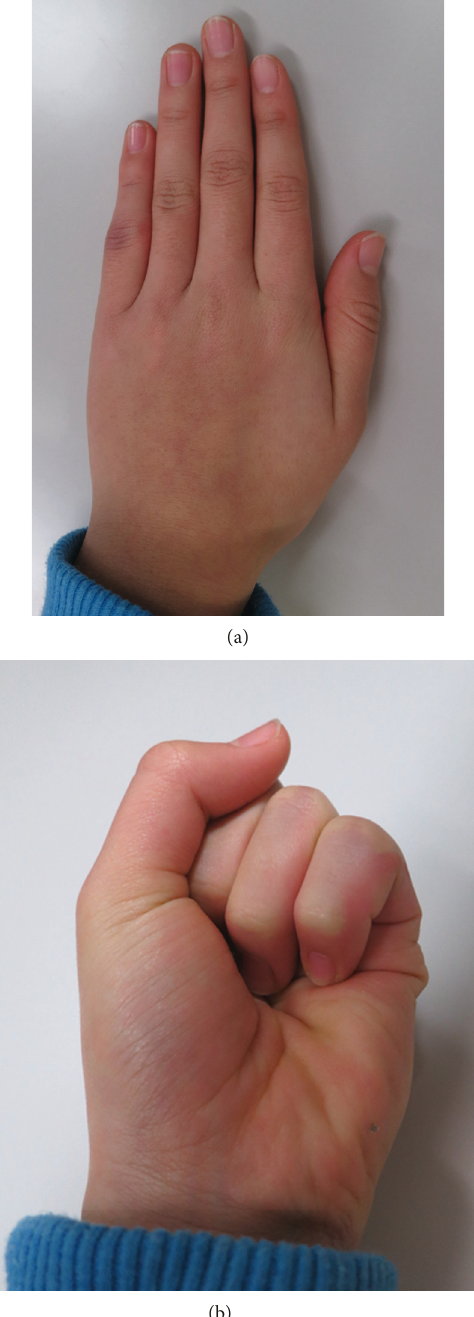
Figure 8: Photographs of Case 2 taken 1 year and 2 months postoperatively. The valgus deformity and overlapping of the left little finger had completely